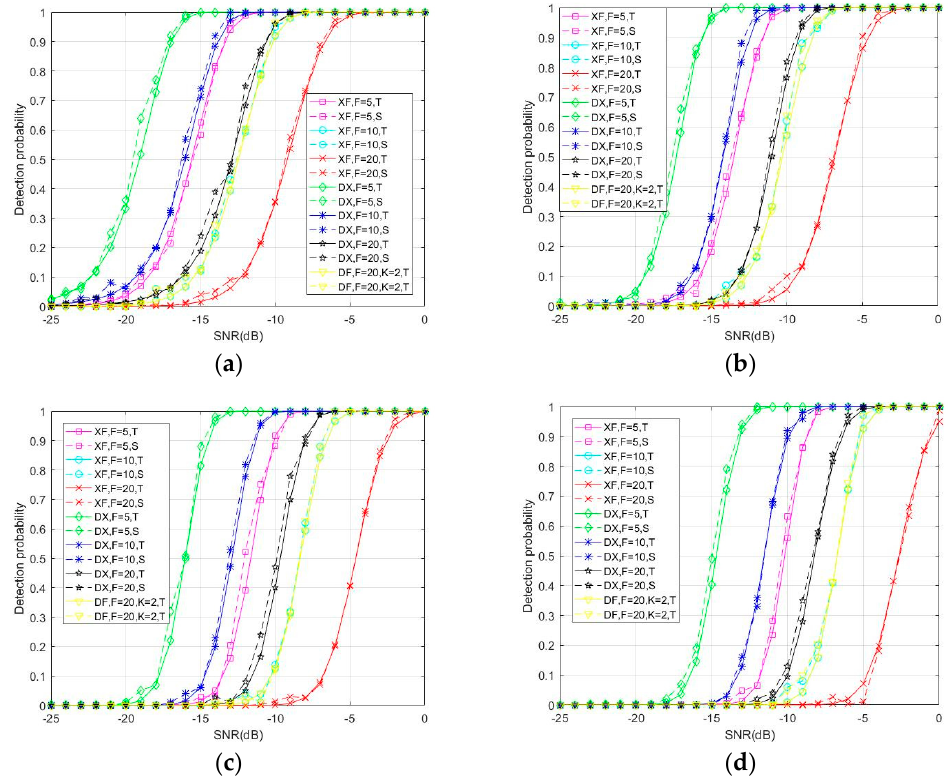
Figure 5. Theoretical (“T”, continuous line) and simulation (“S”, dotted line) results for detection probability under 1–4 verification times ( N (cid:2930)(cid:2918) ) of DC-XFAST (“DX”), DF-XFAST (“DF”) and XFAST (“XF”) with folding number equals to 5, 10 and 20 and N (cid:2930)(cid:2918) equals to 1( a ), 2( b ), 3( c ), 4( d ).